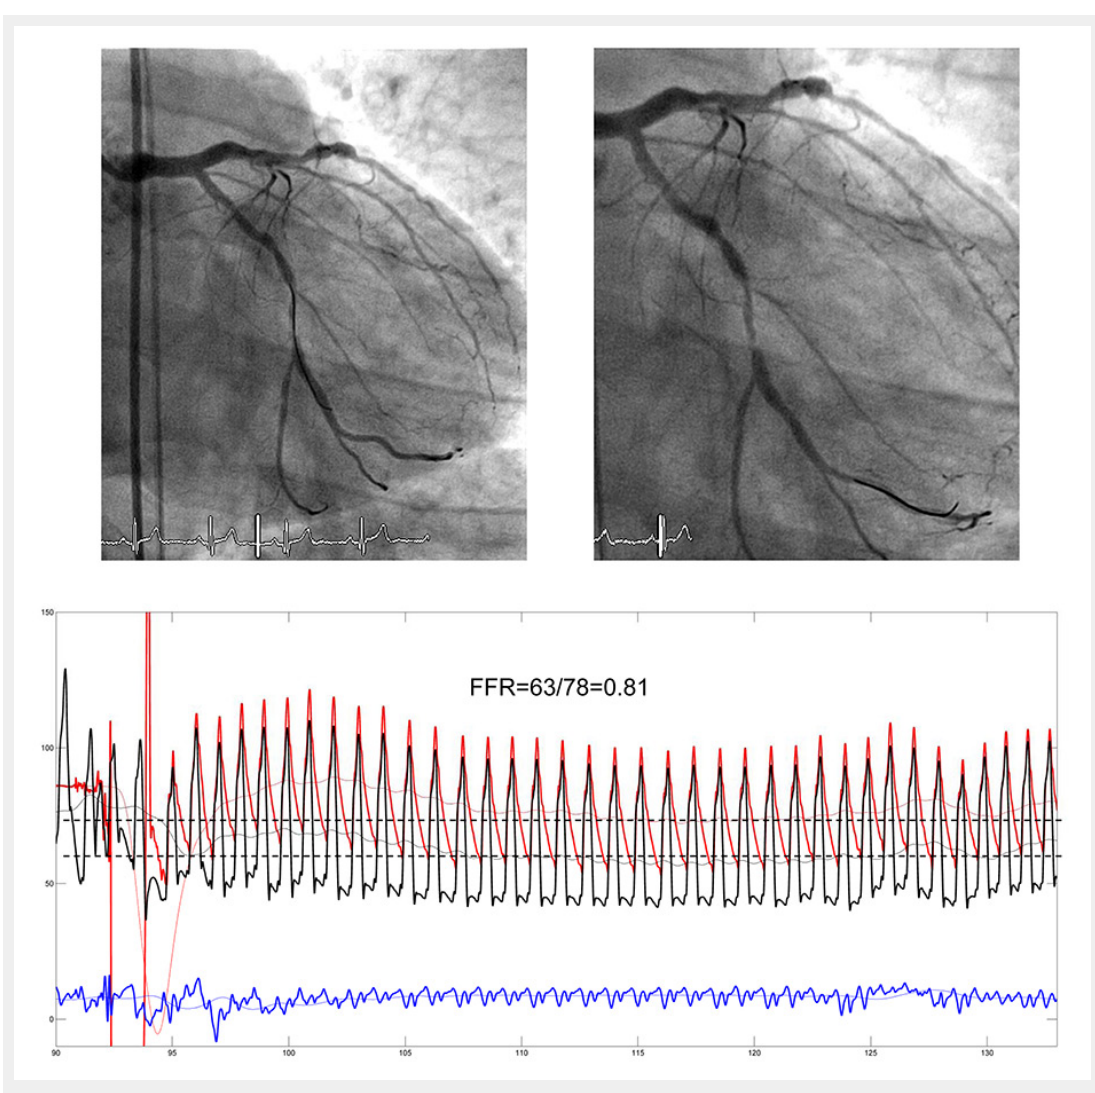
Angiogram of the left coronary artery with serial stenoses of the left circumflex artery (upper panels). The pressure sensor wire (location of the sensor at the end of the opaque tip) is first positioned proximal to the tightest stenosis (left upper panel), and then distal to it (right upper panel). The pressure tracings (lower panel) are recorded with the pressure sensor distal to the stenoses (wire tip in the marginal branch). The following phasic and mean pressures are recorded simultaneously: Aortic pressure, P ao (mean) in red, coronary pressure distal to the stenoses in black (P d ), central venous pressure in blue (CVP). Fractional flow reserve (FFR) is taken as the steady state minimum ratio of P d /P ao (broken lines) over several cardiac